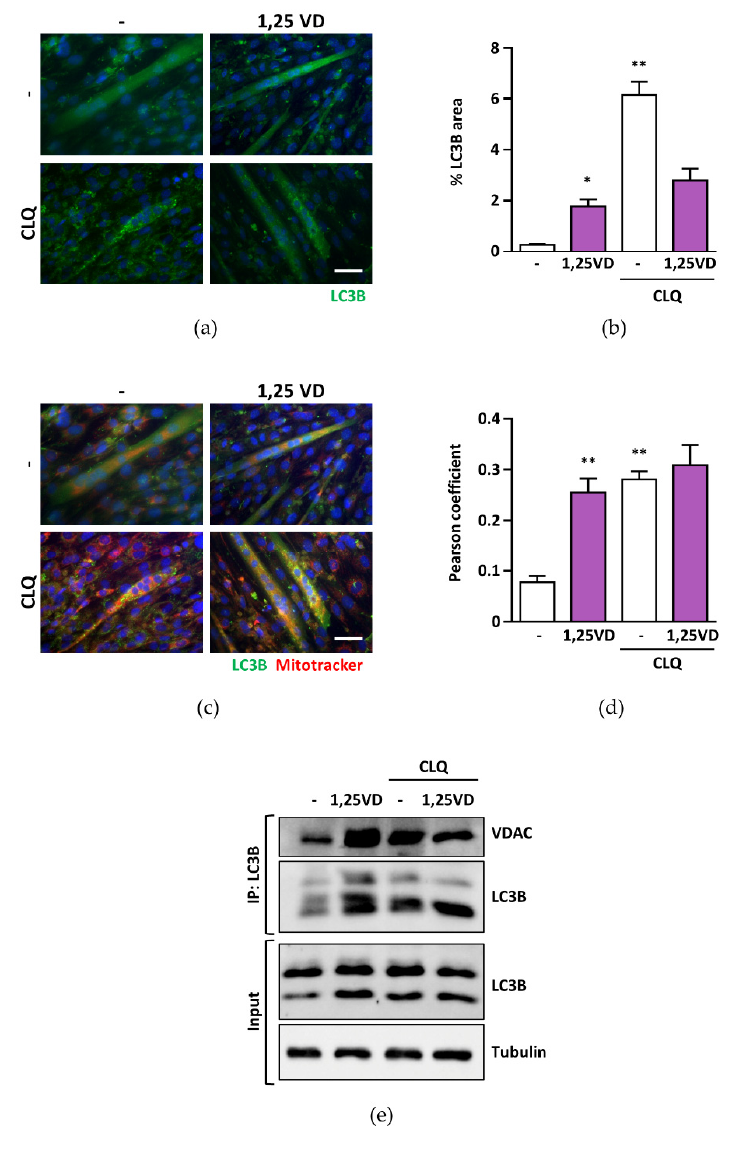
Figure 5. Mitophagic flux is blocked by 1,25VD. C2C12 myotubes were treated in serum-free medium for 24 h with 100 nM 1,25VD in the presence or absence of 10 µ M chloroquine (CLQ). ( a ) Representative images of LC3B immunofluorescence, and ( b ) percentage of LC3B puncta above total myotube area. ( c ) To assess the mitophagic process, mitochondria were stained with MitoTracker™ Red CMXRos and fluorescent images were superimposed to the IF of LC3B; ( d ) colocalization of LC3B and MitoTracker, expressed as Pearson’s coefficient, was analyzed with the JACoP plugin for ImageJ. Scale bar 50 μ m; data are presented as means ± SEM; * p < 0.05; ** p < 0.01. ( e ) Co-immunoprecipitation of LC3B and VDAC in C2C12 myotubes in the absence or presence of chloroquine (CLQ). The interaction LC3B-VDAC was analyzed by immunoprecipitating LC3B followed by VDAC immunoblotting. An amount of 15 μ g of the lysate used for the immunoprecipitation (input) was immunoblotted with anti-LC3B and antitubulin antibodies.